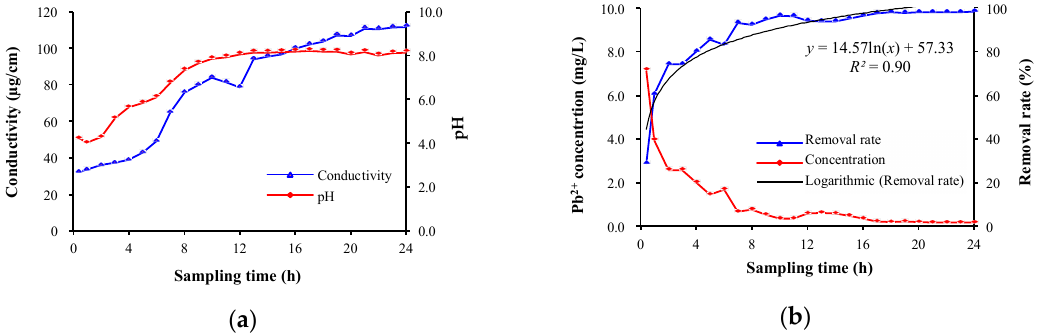
Figure 5. Results of the second artificial rainfall event on the PA system providing 24 h stormwater storage: ( a ) Conductivity and pH values of the stormwater samples; ( b ) Concentration and removal rate of Pb 2+ .